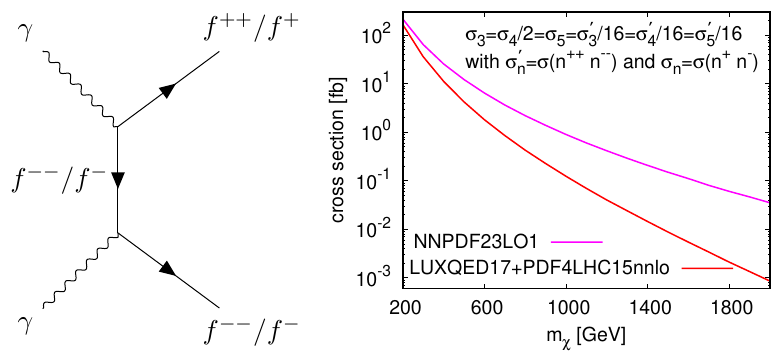
Figure 5 . Feynman diagram for photon initiated pair production of exotic charged fermions. To the right, cross section for photon initiated pair production of exotic charged fermions at 13 TeV